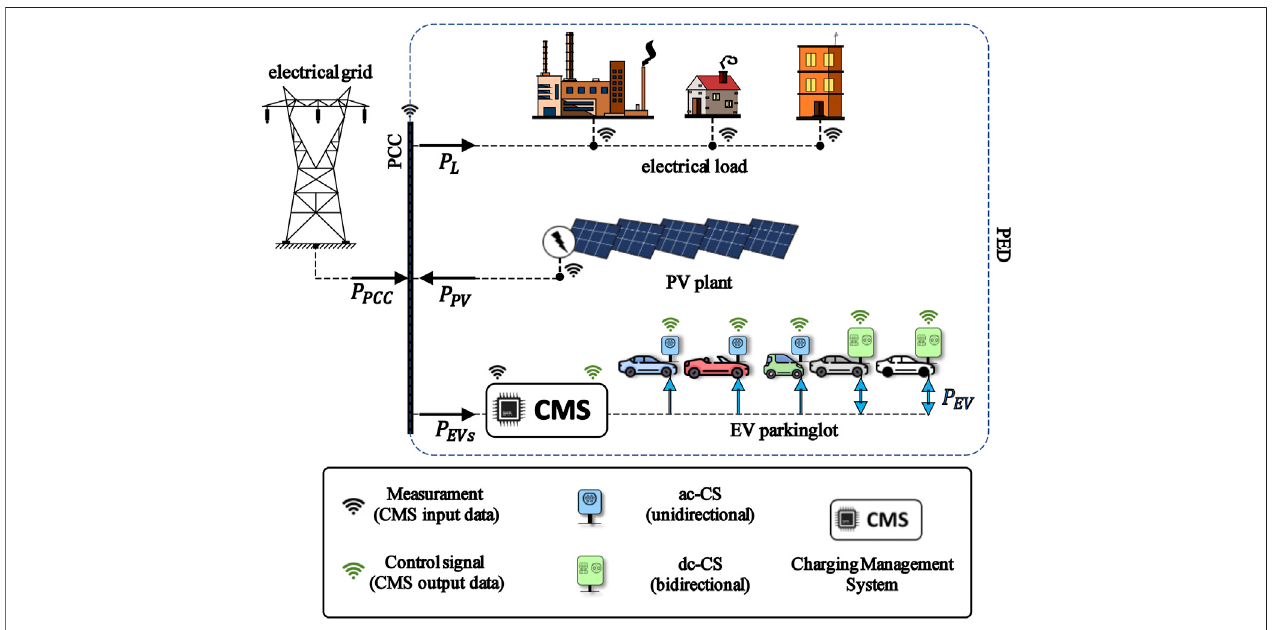
FIGURE 1 | Positive energy district (PED) electrical reference system. PED ’ s power fl ow convention and sharing among grid ( P PCC ), electrical loads ( P L ), internal generation ( P PV ), and EV charging ( P EVs